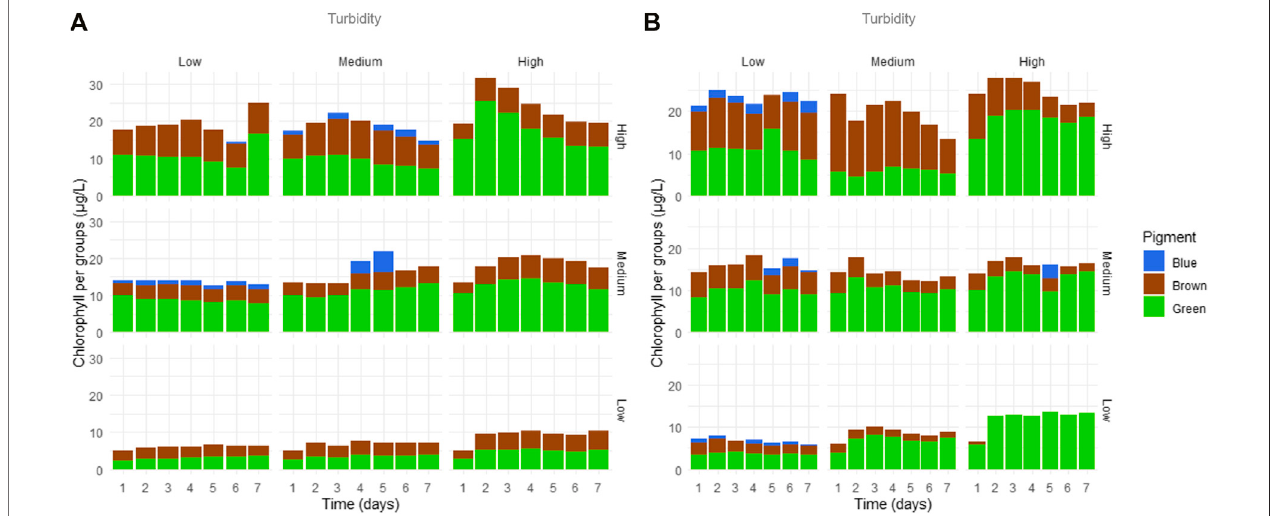
FIGURE 2 | Chlorophyll-a variation ( μ g/L) by time (days) responding to turbidity levels. (A) , NB results; (B) , IB results. Horizontal labels above graphs show initial turbidity levels and vertical lateral labels show chlorophyll-a levels forming experimental design combinations. Colors refer to chlorophyll groups. Chlorophyll-a scales differ between (A) and (B) . NB means Natural Batata and IB means Impacted Batata.